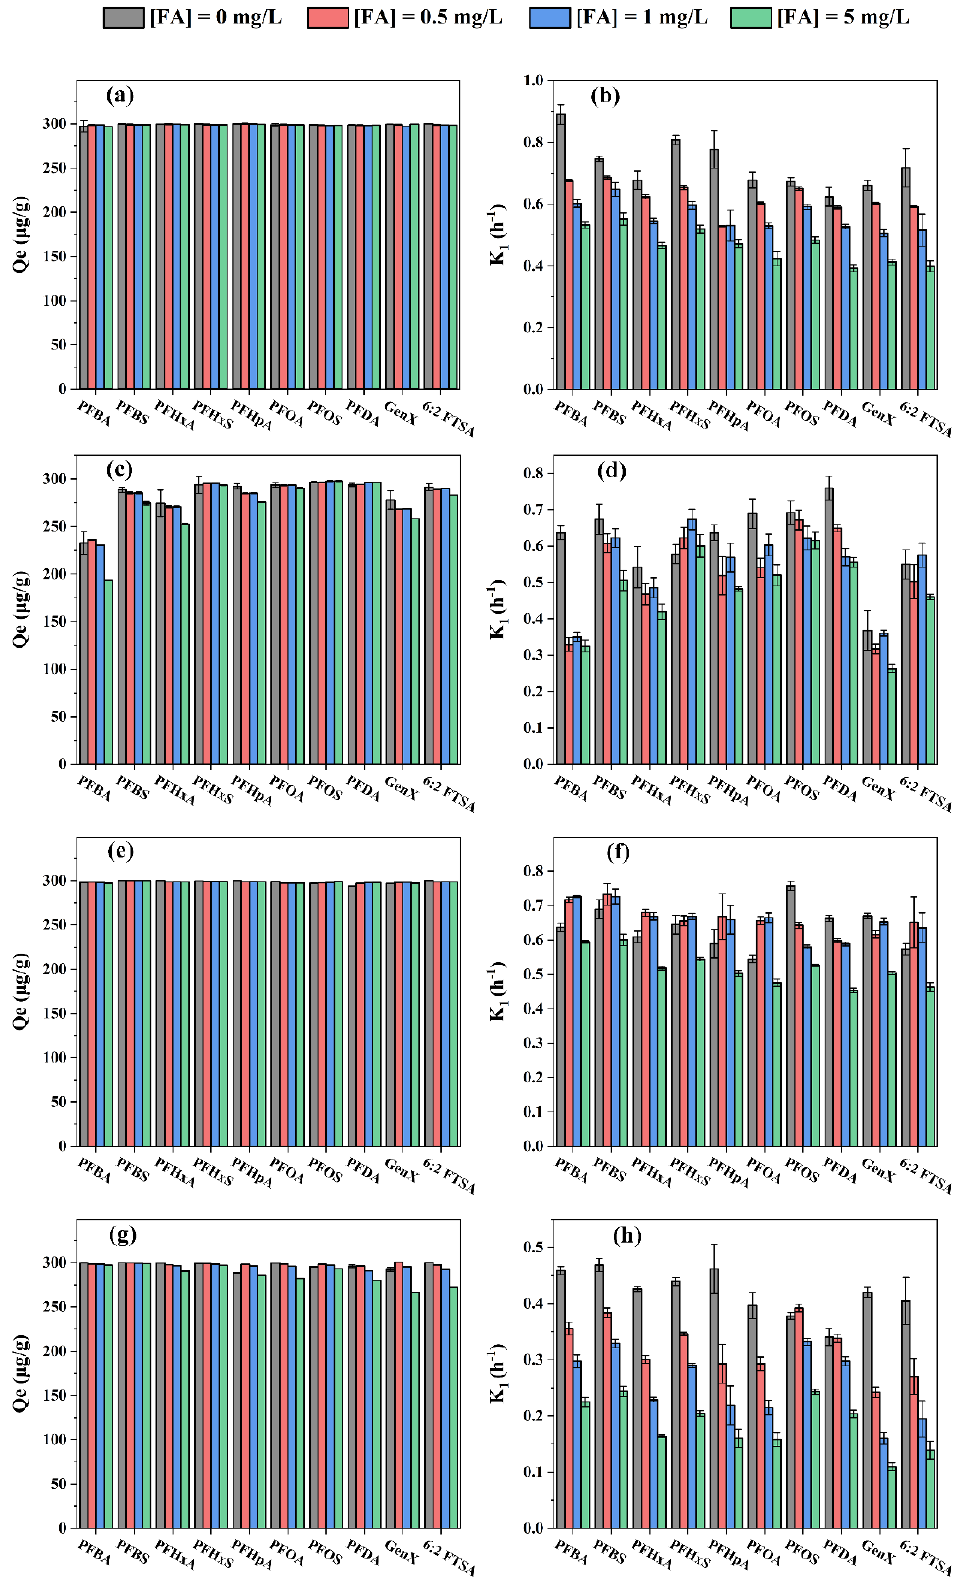
Figure 4. Adsorptive removal of PFASs by various resins in the presence of FA: ( a , b ) HPR4700; ( c , d ) WA10; ( e , f ) S6368; ( g , h ) A111S.